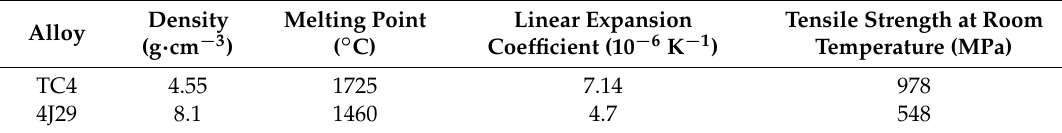
Table 2. Physical properties of base metals.